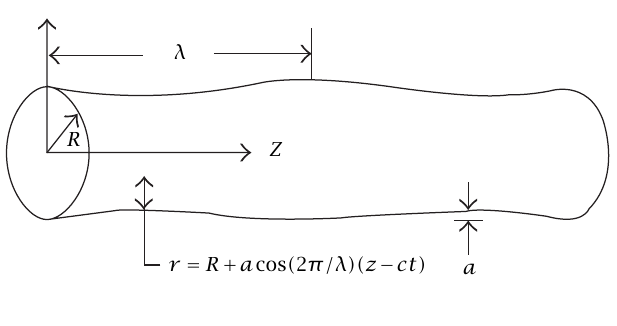
Figure 2.1 Geometry of the